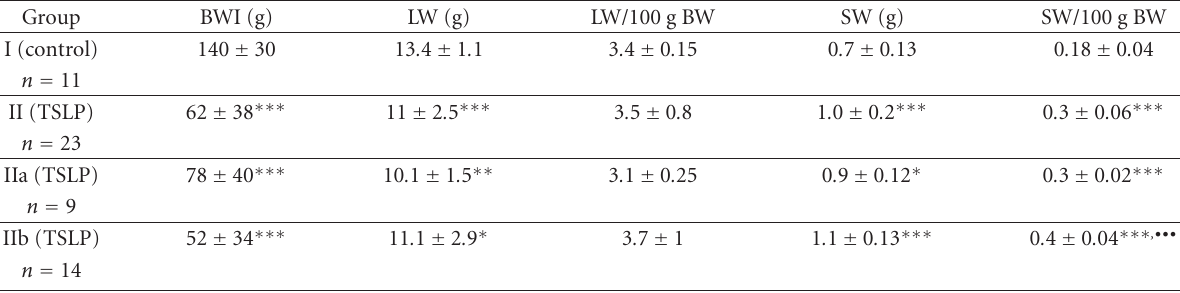
Table 1. Body weight increase (BWI), liver weight (LW), liver weight to body weight (BW), spleen weight (SW), and spleen weight to body weight in the control group (Group I) and in rats with triple stenosing ligation of portal vein (TSLP) (Group II) which, in turn, were divided into Groups IIa (SW/BW < 0 . 29) and IIb (SW/BW ≥ 0 . 30). The results are expressed as mean ± SD. ∗ denotes that P < . 05 in relation to control group, ∗∗ denotes that P < . 01 in relation to control group, and ∗∗∗ denotes that P < . 001 which is a statistically significant value in relation to the control group. ••• denotes that P < . 001 which is a statistically significant value of Group IIb in relation to Group IIa.